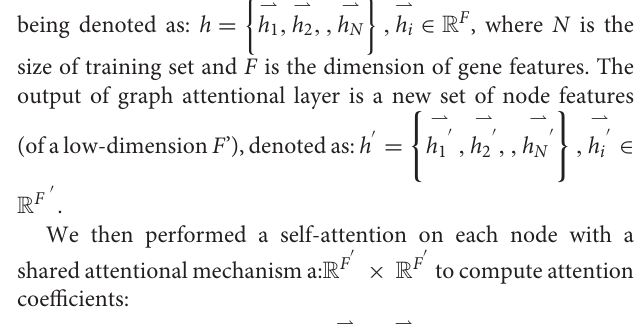
From the gene-lncRNA interaction obtained from lncRNA2Target, we filtered the interactions to make sure each of the training genes is related to at least one lncRNA. As